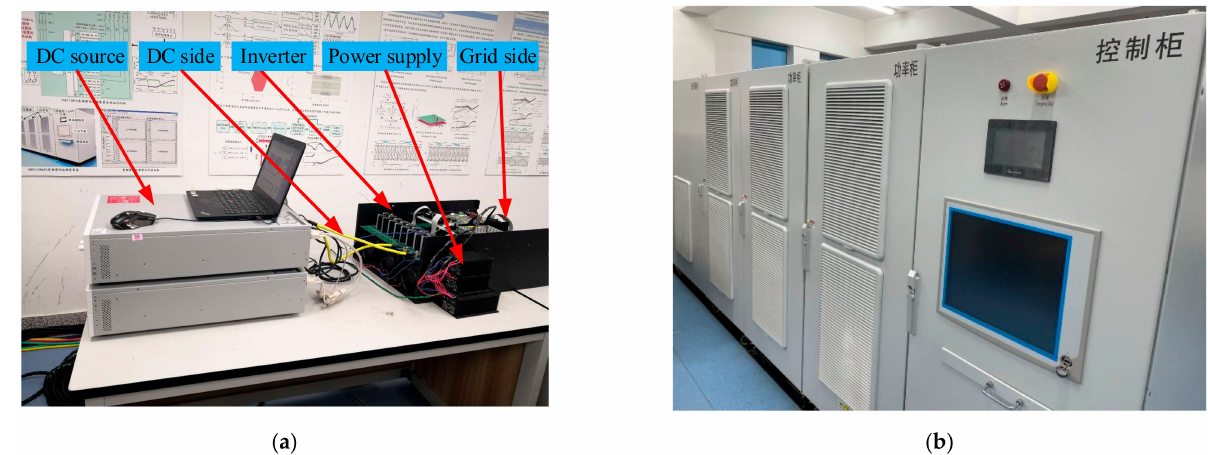
Figure 13. Experimental platform. ( a ) The SCGCS, ( b ) impedance measurement equipment.